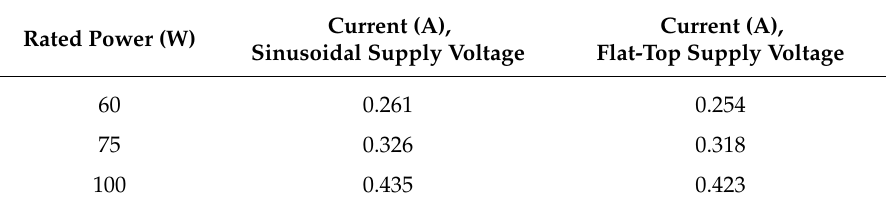
Table 2. Characteristics of incandescent and halogen lamps